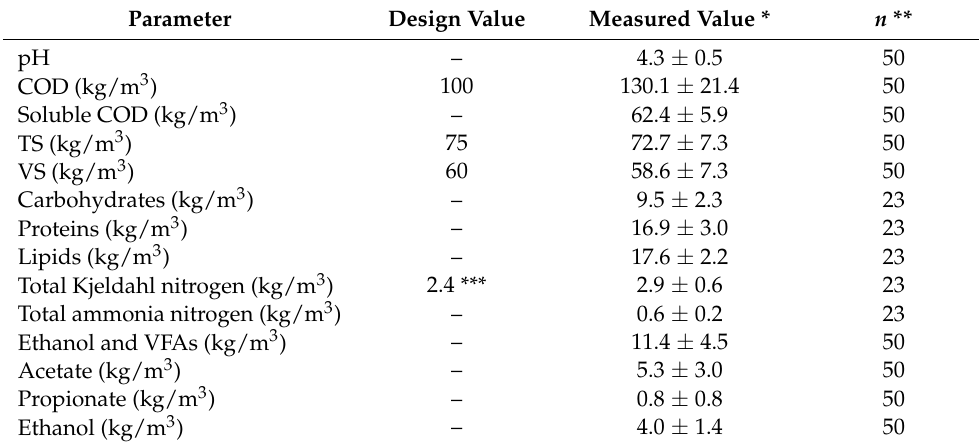
Table 1. The characteristics of the food waste fed into the